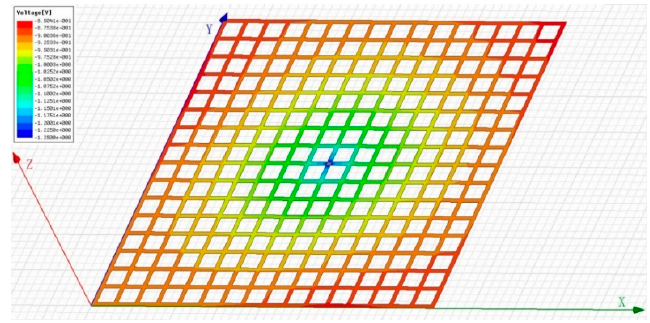
Figure 4. Surface potential distribution map of grounding grid based on simulated annealing optimization.